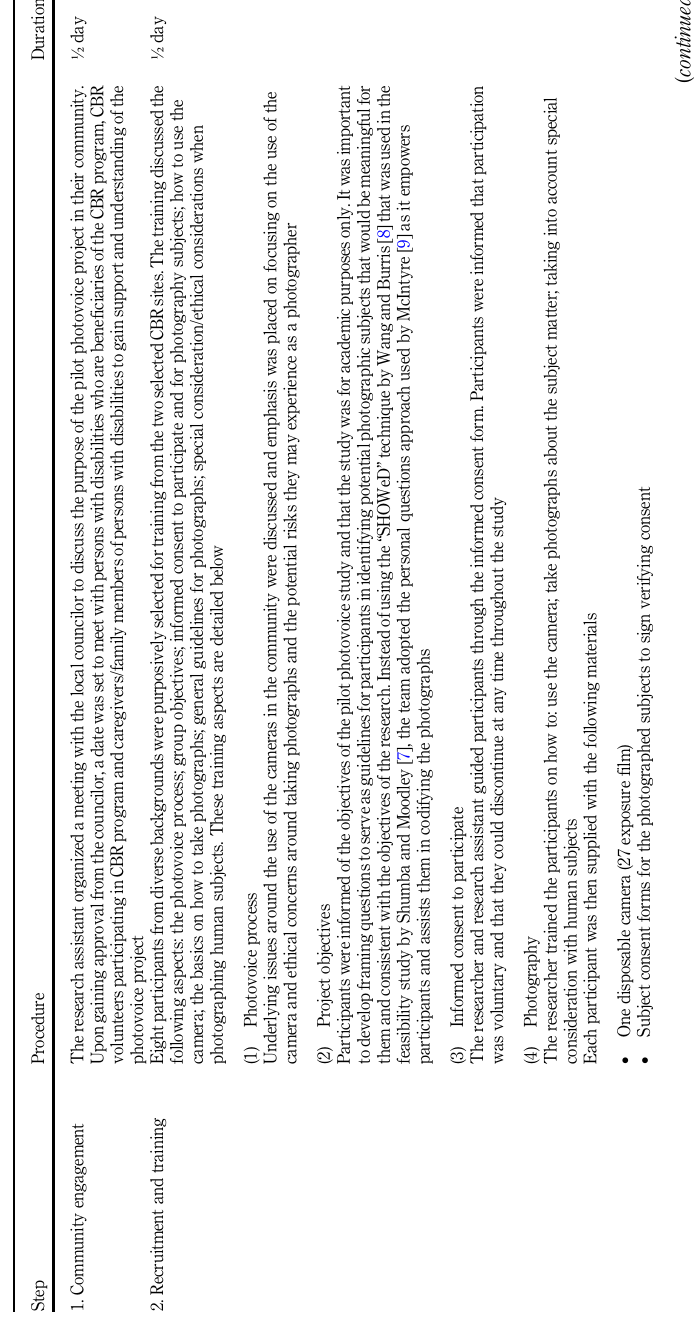
Table 1. Procedure for data collection and